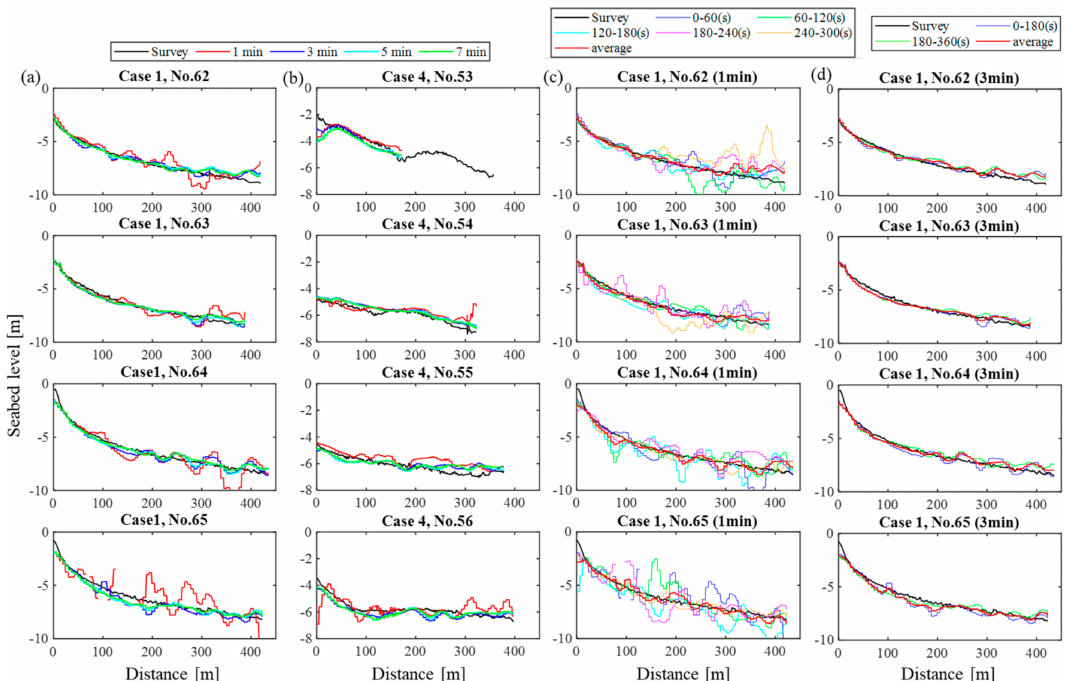
Figure 13. Seabed profiles along the survey transects estimated with different video sub-intervals: ( a ) Seabed profiles estimated with different intervals from the start of the record for Case 1, ( b ) Seabed profiles estimated with different intervals from the start of the record for Case 4, ( c ) Seabed profiles estimated with mutually exclusive 1-min video sub-intervals and their average for Case 1 and ( d ) Seabed profiles estimated mutually exclusive 3-min video subsets and their average for Case